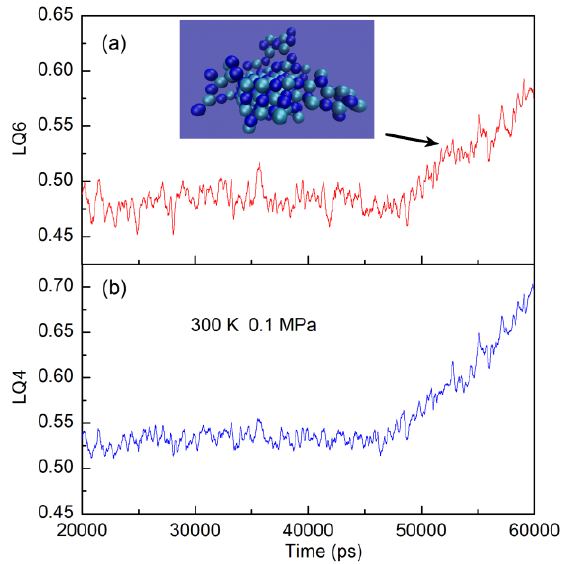
Figure 6. The changes of local Q6 ( a ) and Q4 ( b ) parameter of NaCl solutions (NaCl:H 2 O = 223:2000) during the nucleation. As the nucleation of NaCl crystal occurs, the max aggregate of NaCl (Agg c ) is shown (The ion number is 169).